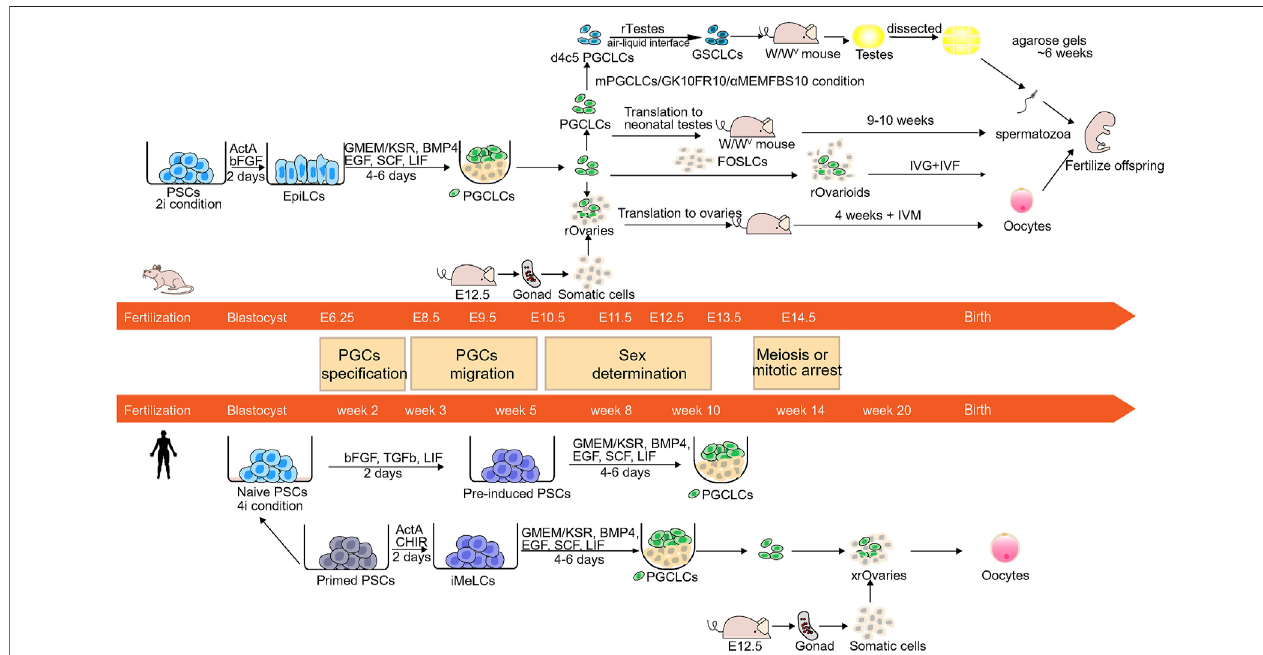
FIGURE1| Schematic ofthe germ celldevelopment and reconstitutionofmPGCLCs and hPGCLCs in vitro . The centeris theimage shows developmental stages and the timeline of mouse and human germ cell development. PGCs undergo speci fi cation, migration, sex determination, and meiosis or mitotic arrest before birth. The upper and lower panels show the induction of mPGCLCs and